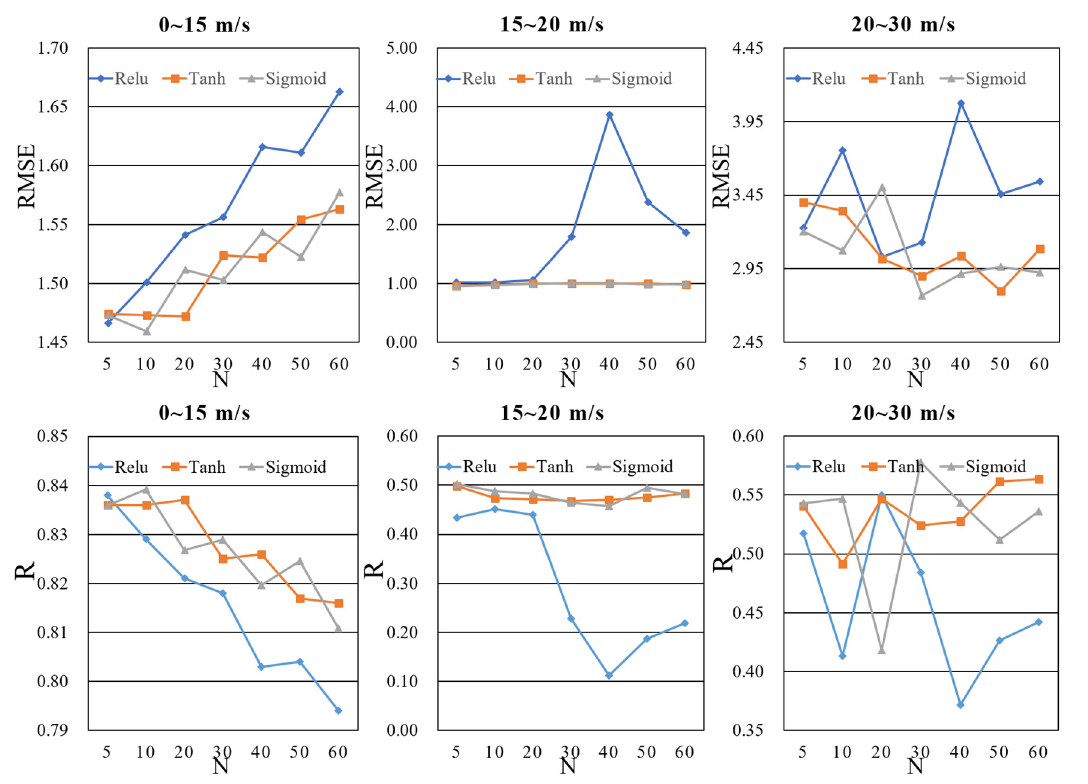
Figure 8. RMSEs and Rs of the wind speed retrieval models using ANN models with different activation functions and different numbers of neurons.